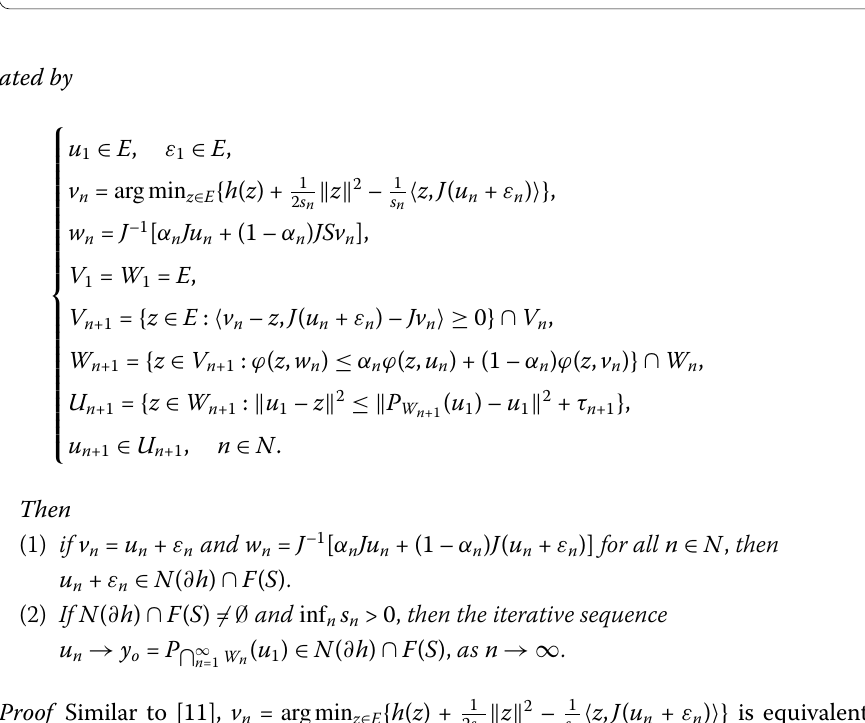
Figure 2 Convergence of { u n } , { v n } , and { w n }